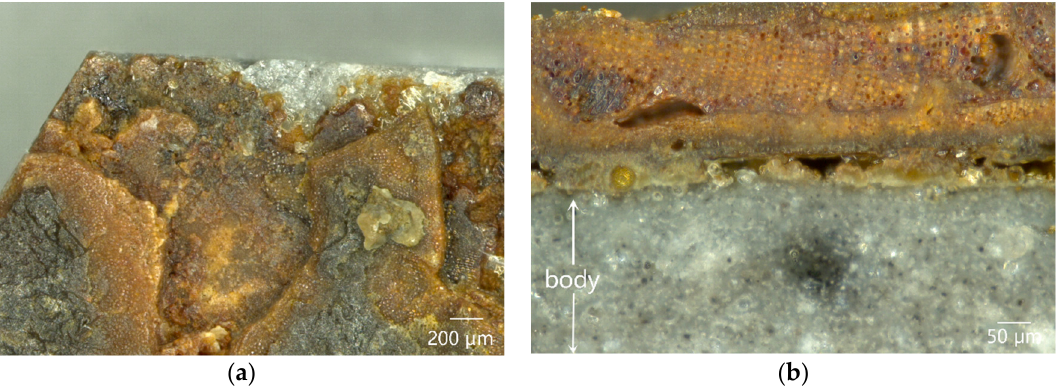
Figure 7. OM images of cellular-structure coagula attached to the outer surface of sample DL-1: ( a ) surface and ( b ) cross-section.